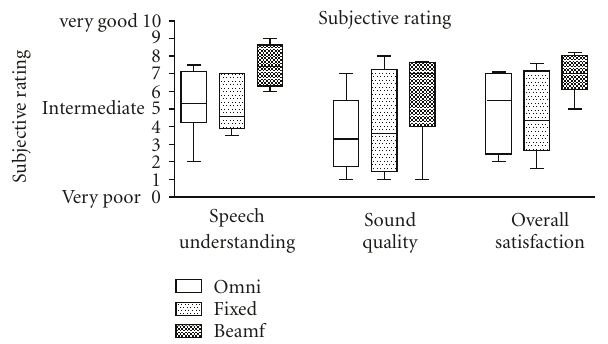
Figure 11: Speech reception thresholds (SRT) of six cochlear implant users for noise arriving from the back, and the target signal arriving from the front.